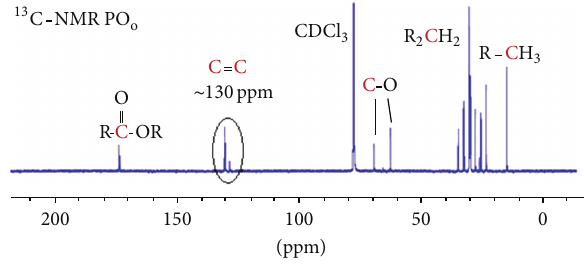
Figure 2: The 13 C-NMR spectrum of PO